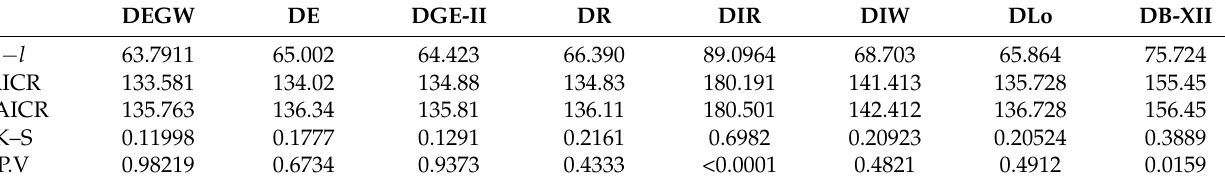
Table 16. The goodness-of-fit test statistics for comparing the competitive models for dataset II.